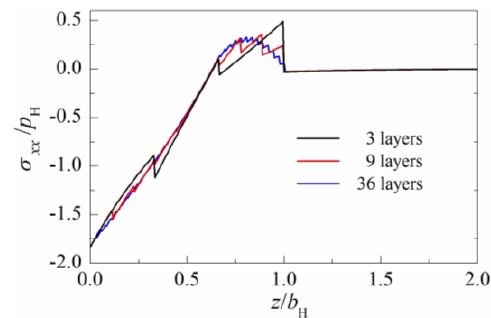
Figure 8. Stress σ xx along z axis of multilayered solids with a similar structure layout but a different layer number when μ f = 0.